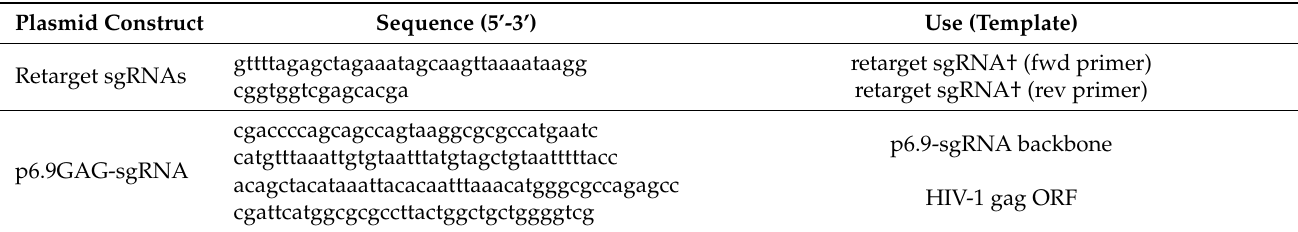
Table 1. Primers used in this study.